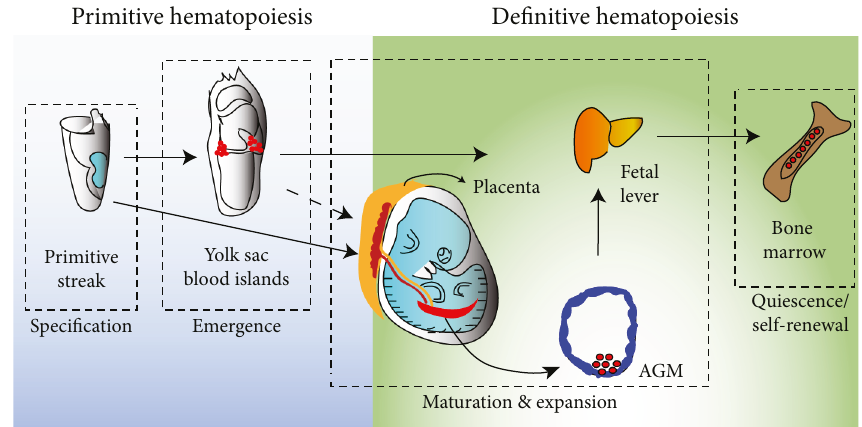
Figure 1: Embryonic hematopoiesis. Establishment of primitive and de fi nitive HSCs during embryonic